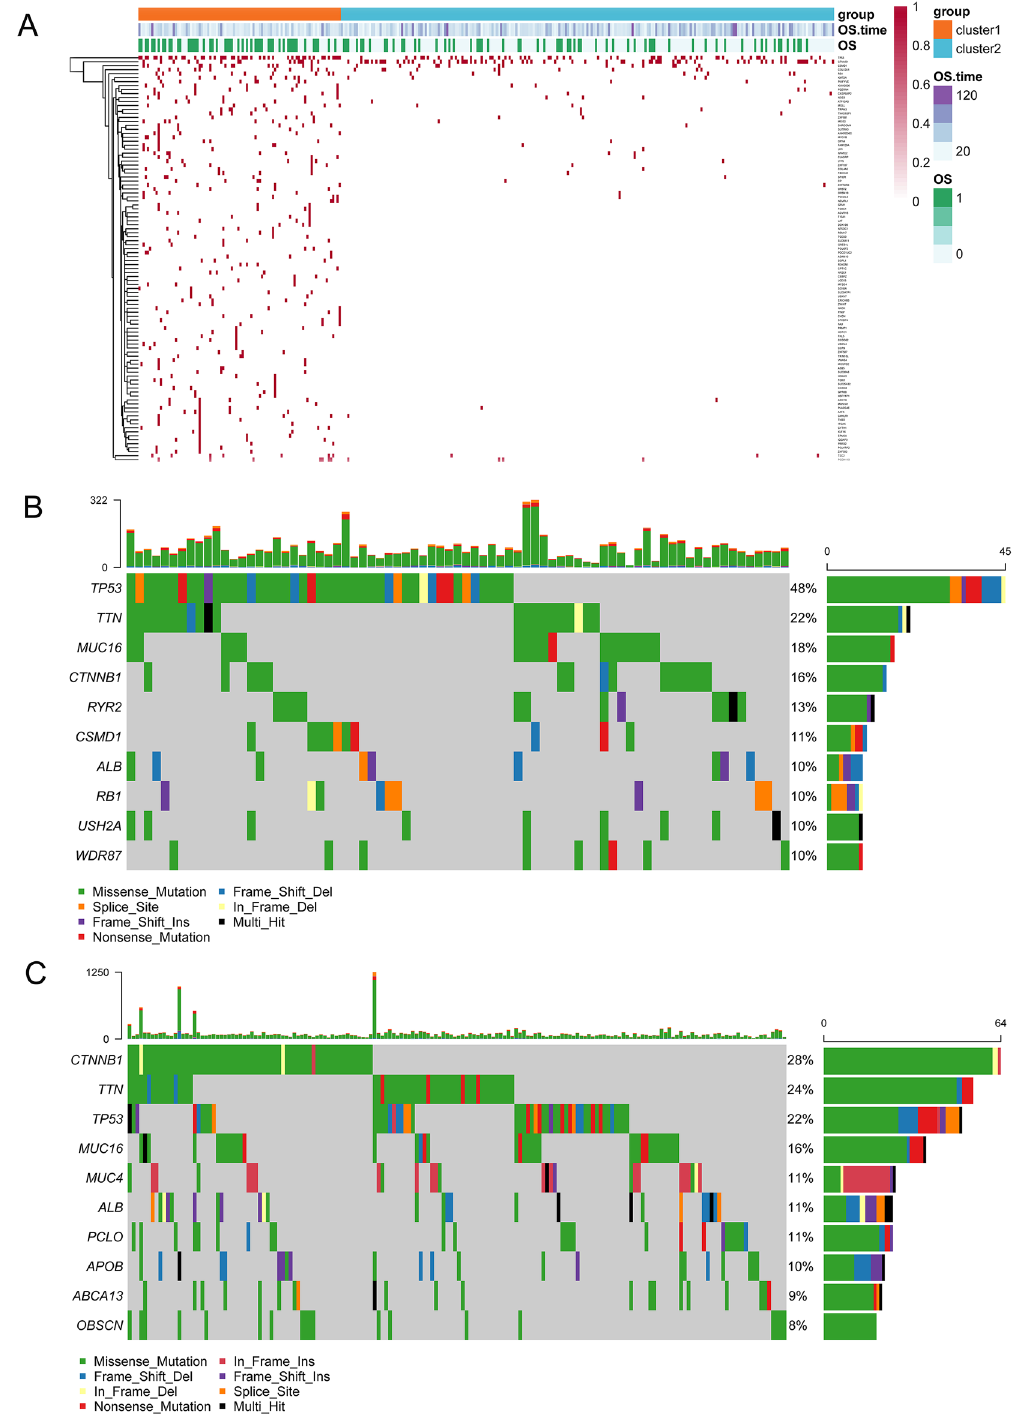
Figure 3. Mutation distribution of high-frequency mutation genes in the two molecular subtypes. ( A ) Heatmap of gene mutations (the gene mutations refer to SNVs only) with significant differences in mutation frequency between two subtypes. 0 indicates alive, and 1 indicates dead. Red dots indicate mutations and white dots indicate no mutations. The mutation distribution of top10 high-frequency mutation genes in ( B ) cluster1 and ( C ) cluster2. The barplot at the top indicate total number of different types of mutations in a